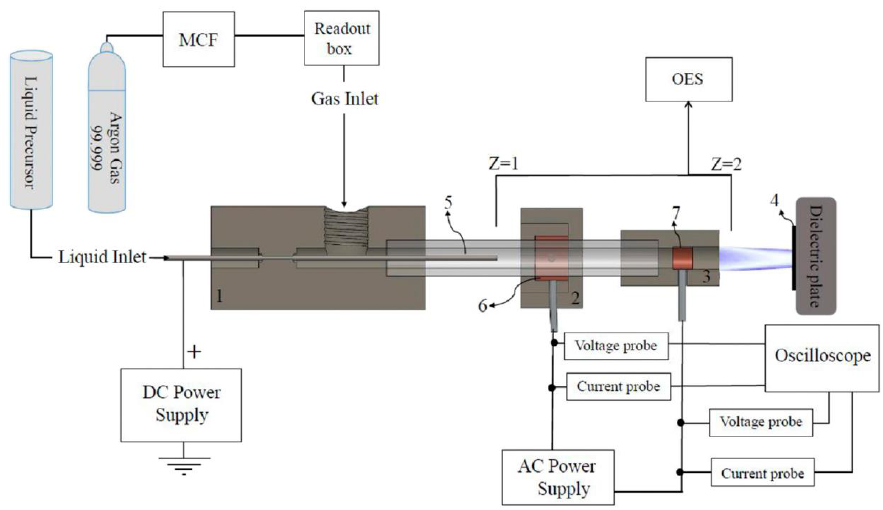
Figure 14. Schematic of a combination of electrospray and atmospheric pressure argon plasma jet [84].